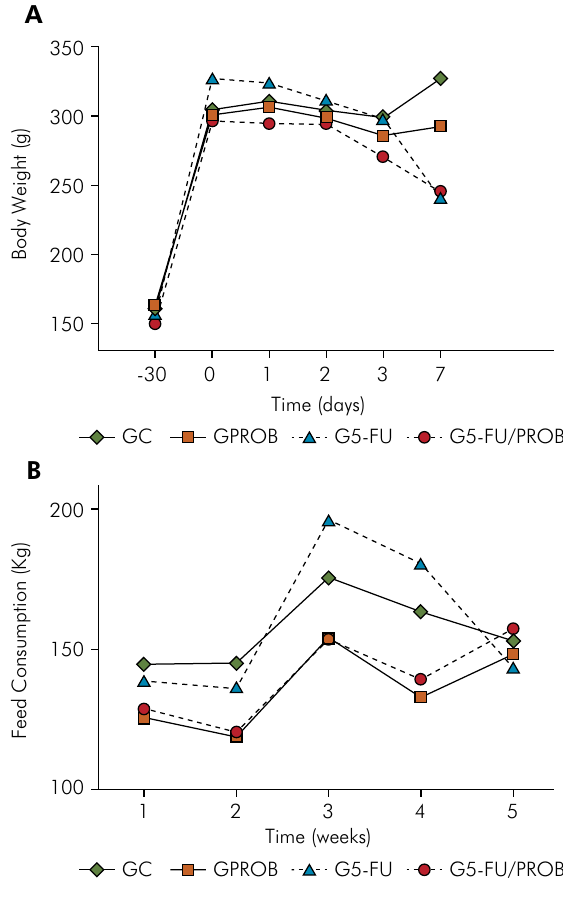
Figure 1. A: Body weight variation of all groups throughout the experimental period; B: Feed consumption variation of all the groups throughout the experimental